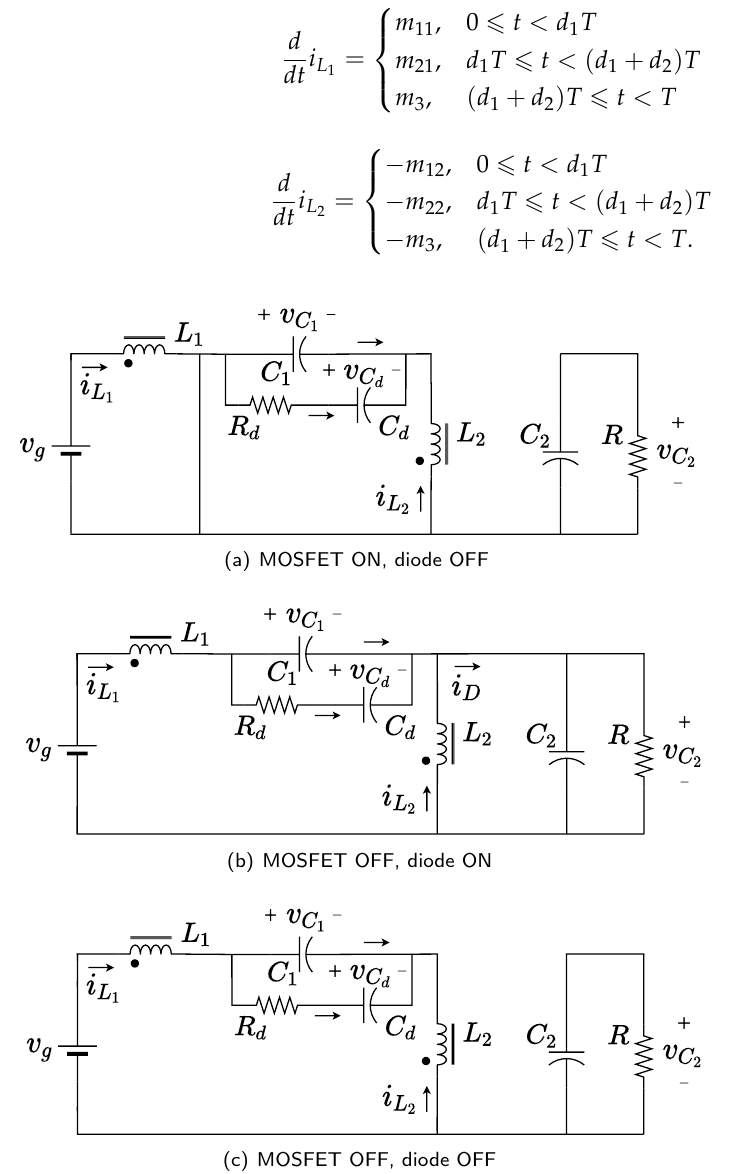
Figure 2. SEPIC converter circuits on DCM operation: ( a ) MOSFET ON, diode OFF, ( b ) MOSFET OFF, diode ON, ( c ) MOSFET OFF, diode